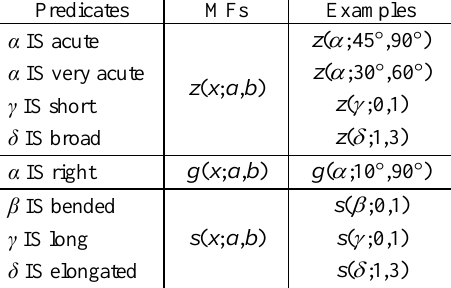
Table 2 Predicates in fuzzy